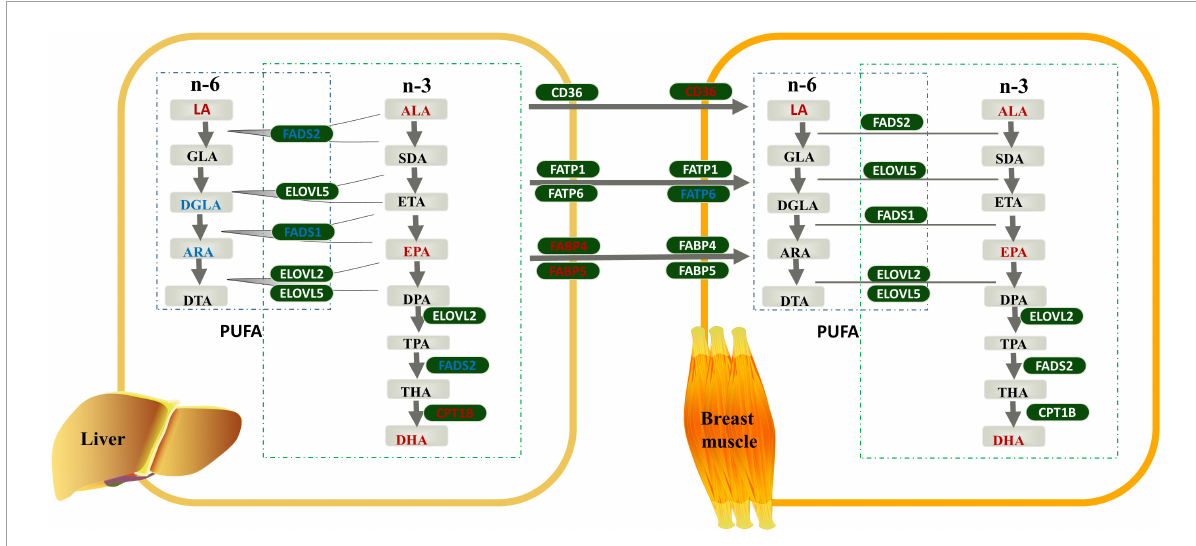
FIGURE5 Effects of linseed oil on the polyunsaturated fatty acid (PUFA) synthesis and transport pathways in duck liver and breast muscle. Green boxes indicate genes, gray boxes indicate metabolites, red font indicate upregulated, blue font indicate downregulated.